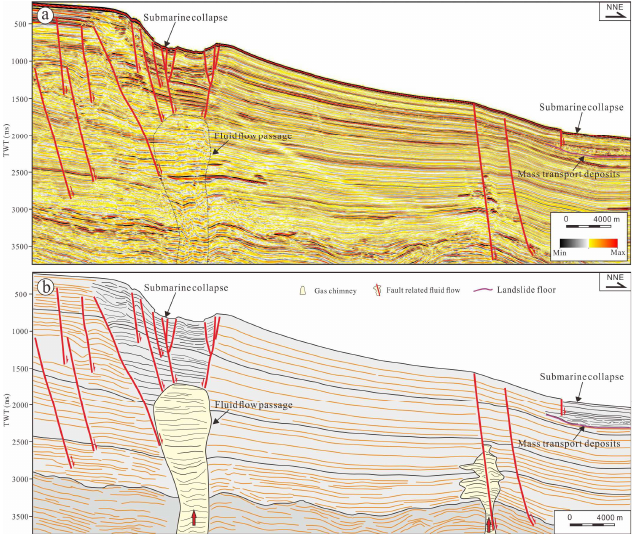
Figure 7. Seismic profile ( a ) and geological interpretation ( b ) showing the submarine collapse with fluid flow passage below and mass transport deposits at the middle- and lower-continental shelf slope. Dense normal faults developed in this area. Large-scale fluid flow passage appears beneath the submarine collapse. The location of Figure 7 correspond to the red line F in Figure 1.